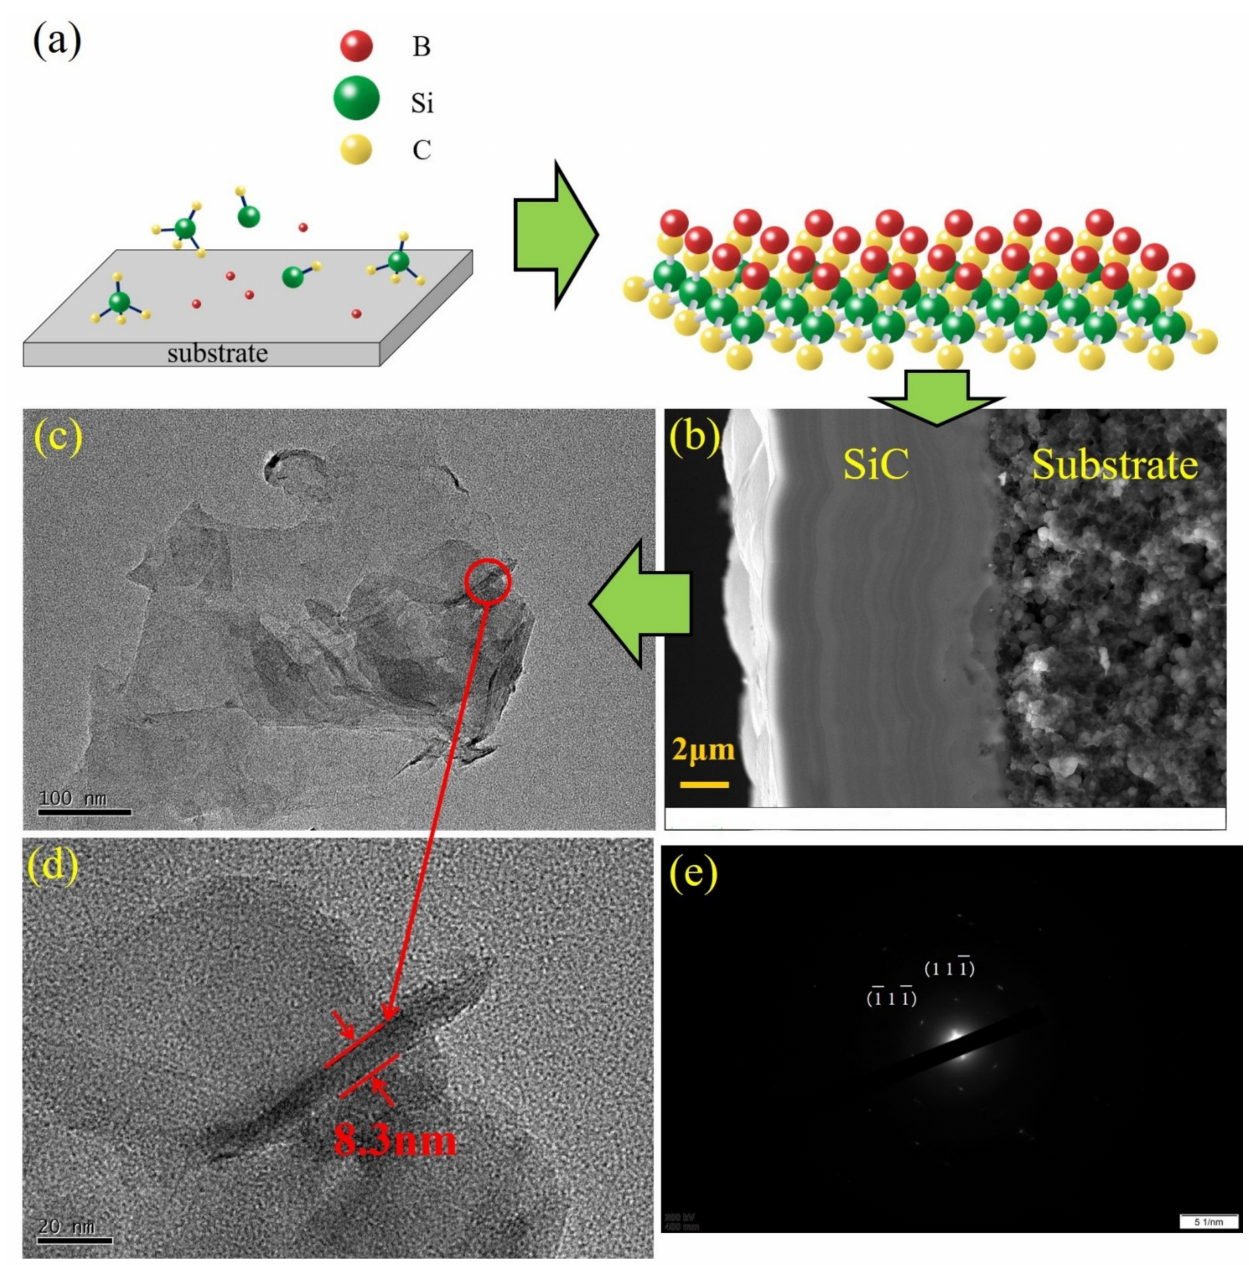
Figure 1. ( a ) Fabrication process of the SiC nanosheets. ( b ) SEM image of the cross section. ( c ) TEM image of the single SiC nanosheet. ( d ) TEM image of the single SiC nanosheet. ( e ) SAED result for the SiC